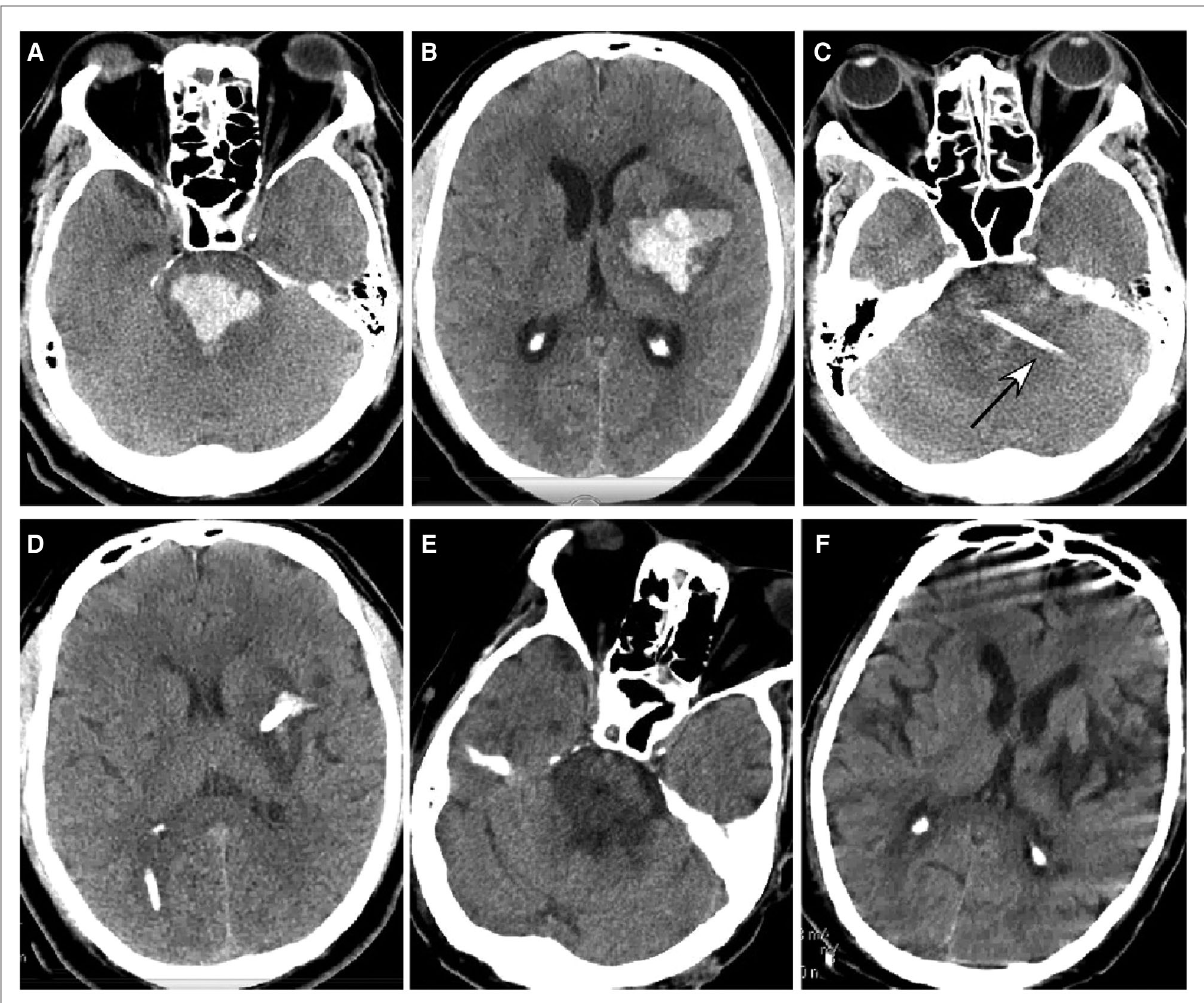
FIGURE 4 Brainstem hemorrhage. ( A , B ) A 45-year-old man had a sudden loss of consciousness 1 h before presentation. Head CT scan ( A , B ) showed severe hemorrhage in the brainstem, thalamus, and basal ganglia. The patient was in a coma with a Glasgow Coma Scale (GCS) score of 3 (E1VTM2). ( C , D ) An ultra-early stereotactic aspiration was performed (arrow). ( E , F ) Three months after surgery, the patient had a GCS score of 6 (E3VTM4) and was in active